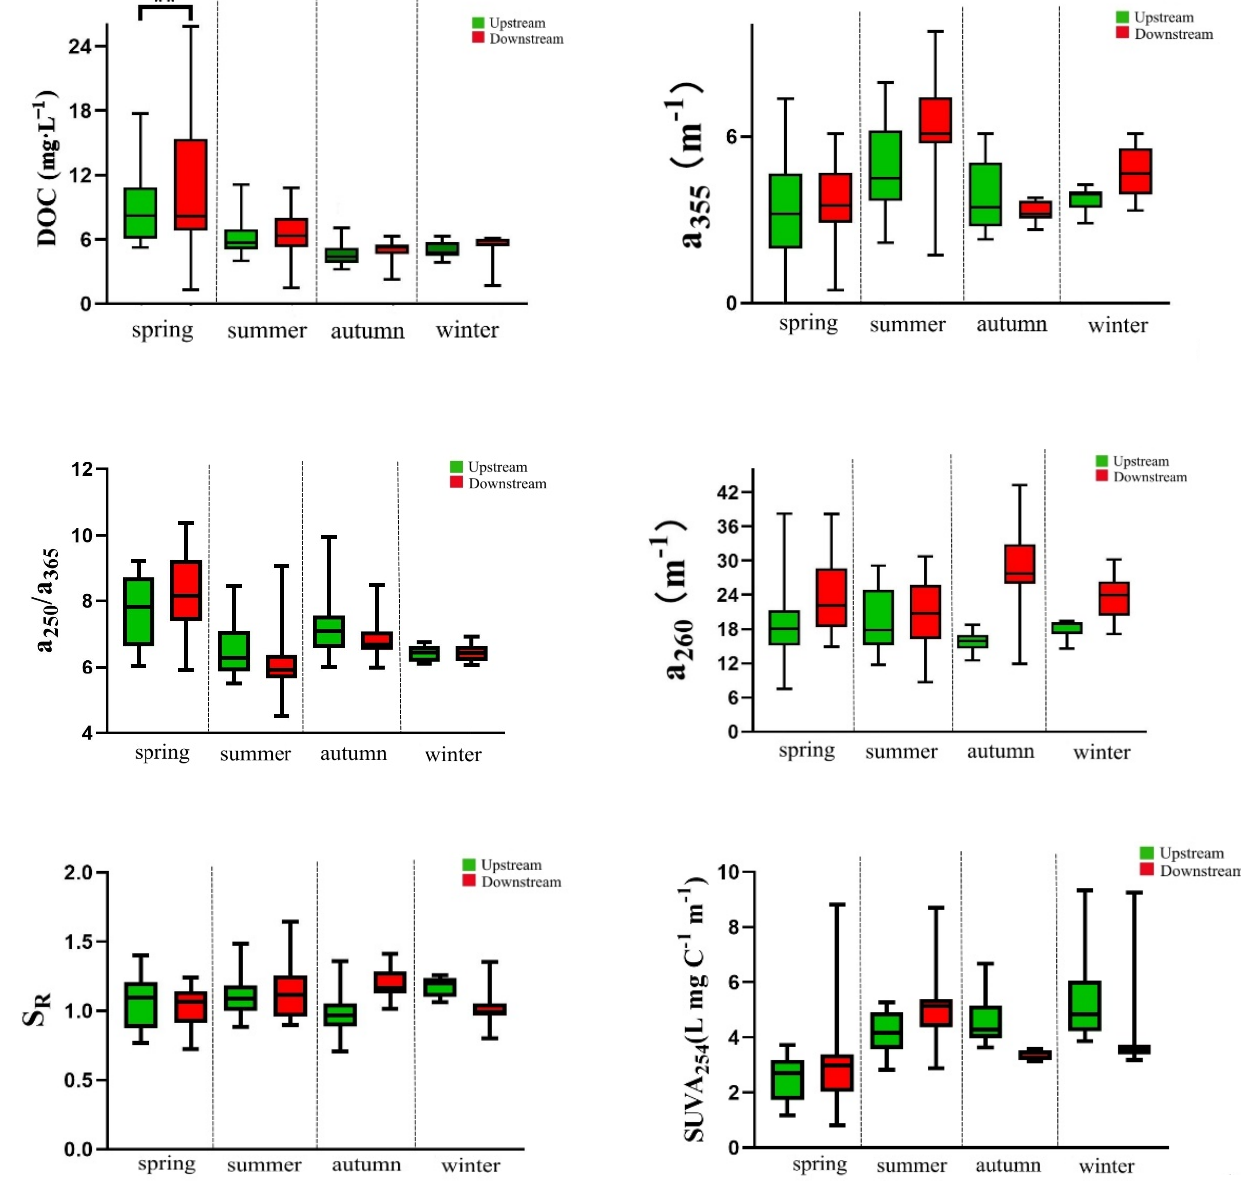
Figure 2. Box plot of DOC concentrations and seasonal absorption indexes in three rivers. The solid line inside the box represents the median. The horizontal edges of the boxes denote the 25th and 75th percentiles. ** was sig. at the confidence level of 0.01.